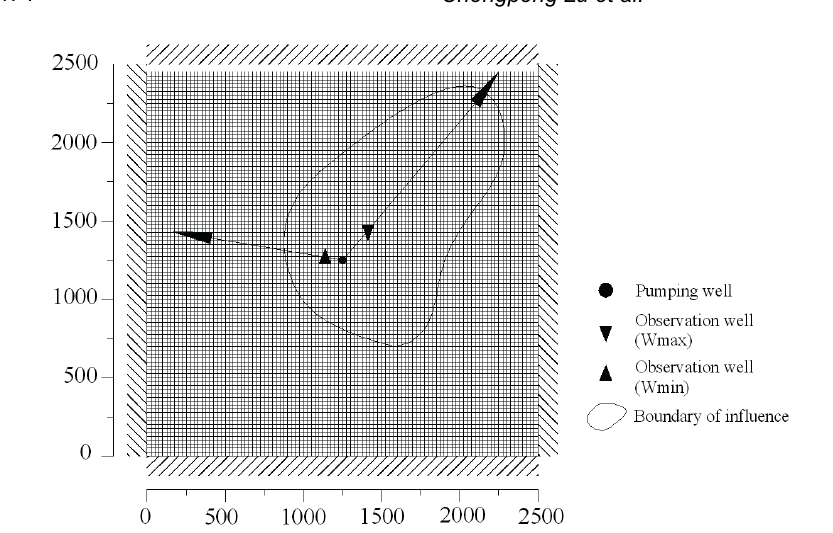
Fig. 2 The planar map of the model domain with a random K